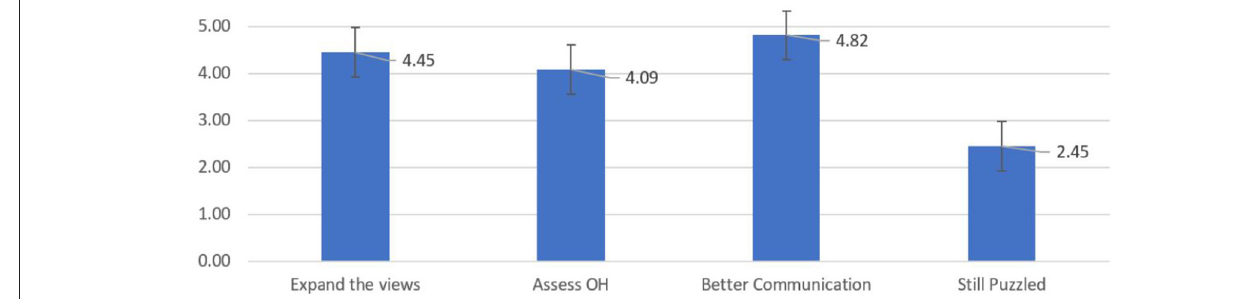
FIGURE 2 | Results of final assessment. Scale from 1 = disagree to 5 = agree.